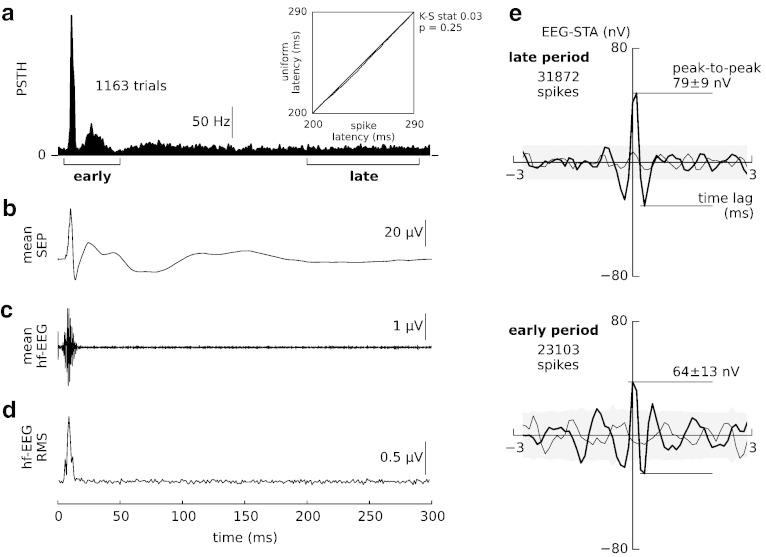
Stimulus-evoked components do not affect the EEG-STA. (a) The post-stimulus time histogram (PSTH, bin width 1 ms; 1163 trials were used in panels a–d) of a single neuron shows a prominent early response (5–50 ms post-stimulus — left bracket). Spike occurrences in the late window (200–290 ms post-stimulus — right bracket) are well approximated by a uniform distribution (inset: quantile–quantile plot comparing the observed spike latencies, abscissa, to uniform distribution, ordinate) confirming the stationarity of spike rate in the late window (Kolmogorov–Smirnov test, p > 0.05). (b) Epidural wide-band somatosensory evoked potentials (SEPs). (c) A stimulus-evoked burst of high-frequency epidural EEG (EEG burst, band-pass filtered, 800–3000 Hz) appears 8–18 ms post-stimulus. (d) Averaging squared high-frequency EEG single trials (RMS — root–mean–square amplitude) to prevent cancellation of oscillations incoherent across trials does not reveal any stimulus-induced activity at post-stimulus latencies > 20 ms. (e) The grand-average EEG-STAs (thick lines) calculated separately for the two post-stimulus periods delimited by brackets in (a): “late” (top) and “early” (bottom). Shuffling spikes across trials removed peaks in both averages (shift predictor, thin lines). No baseline correction was applied to the late-period EEG-STA and its shift predictor.